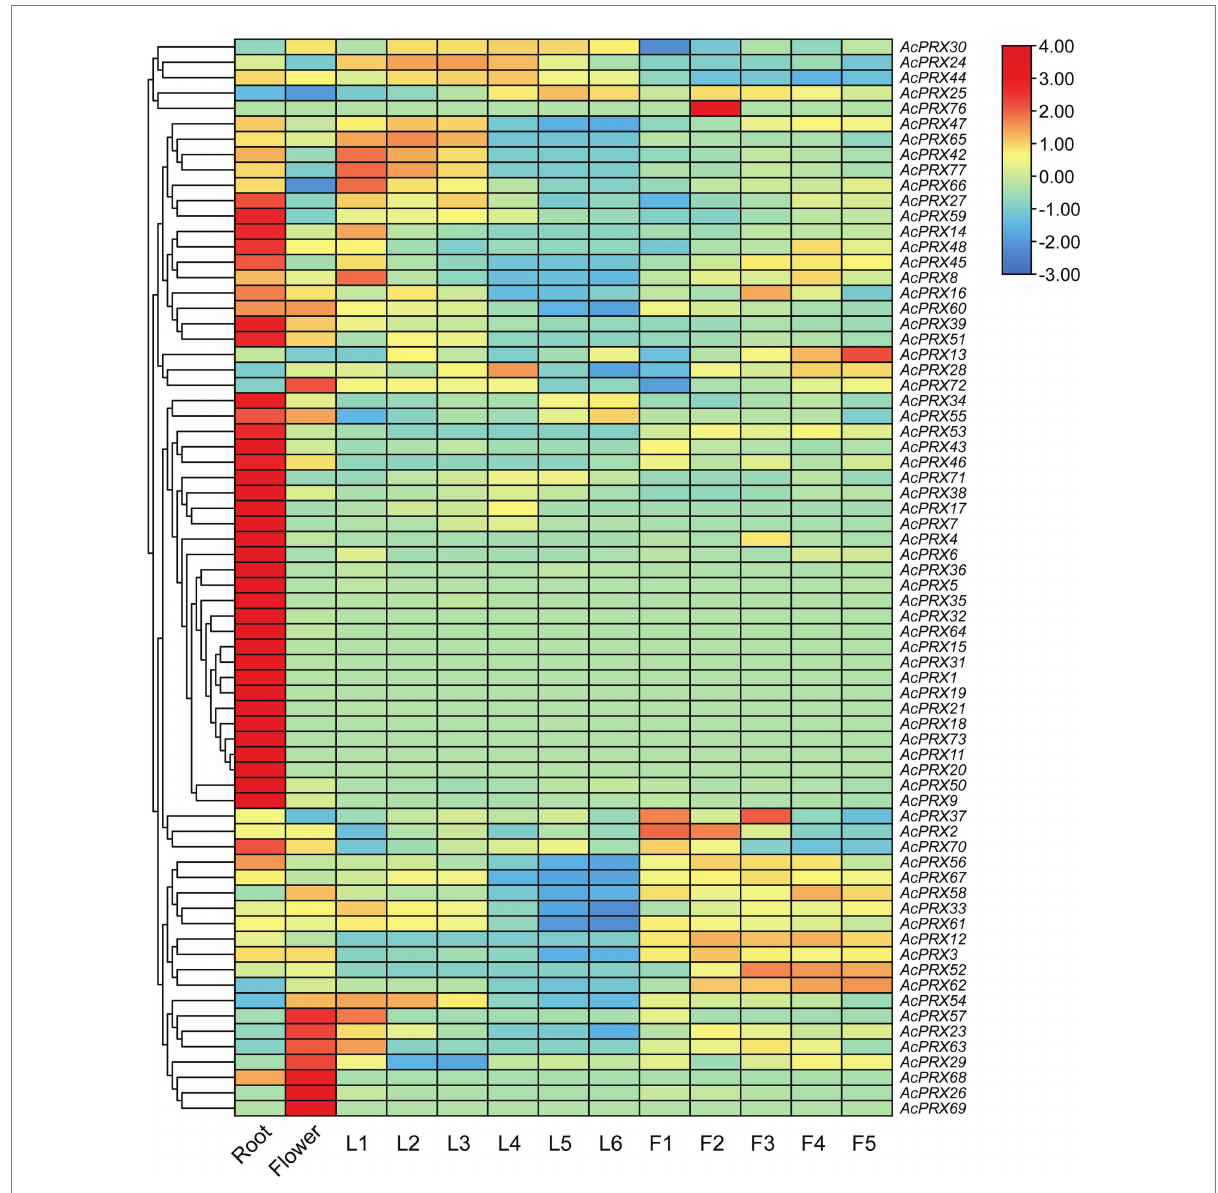
FIGURE 8 Expression pattern analysis of AcPRXs in different tissues and developmental stages in pineapple. Gene expression is shown as the log 2 transformation of fragments per kilobase of exon per million mapped fragments (FPKM) values. AcPRXs are clustered based on their phylogenetic relationships. Relative expression values are represented by colour, with red showing high expression and blue showing low